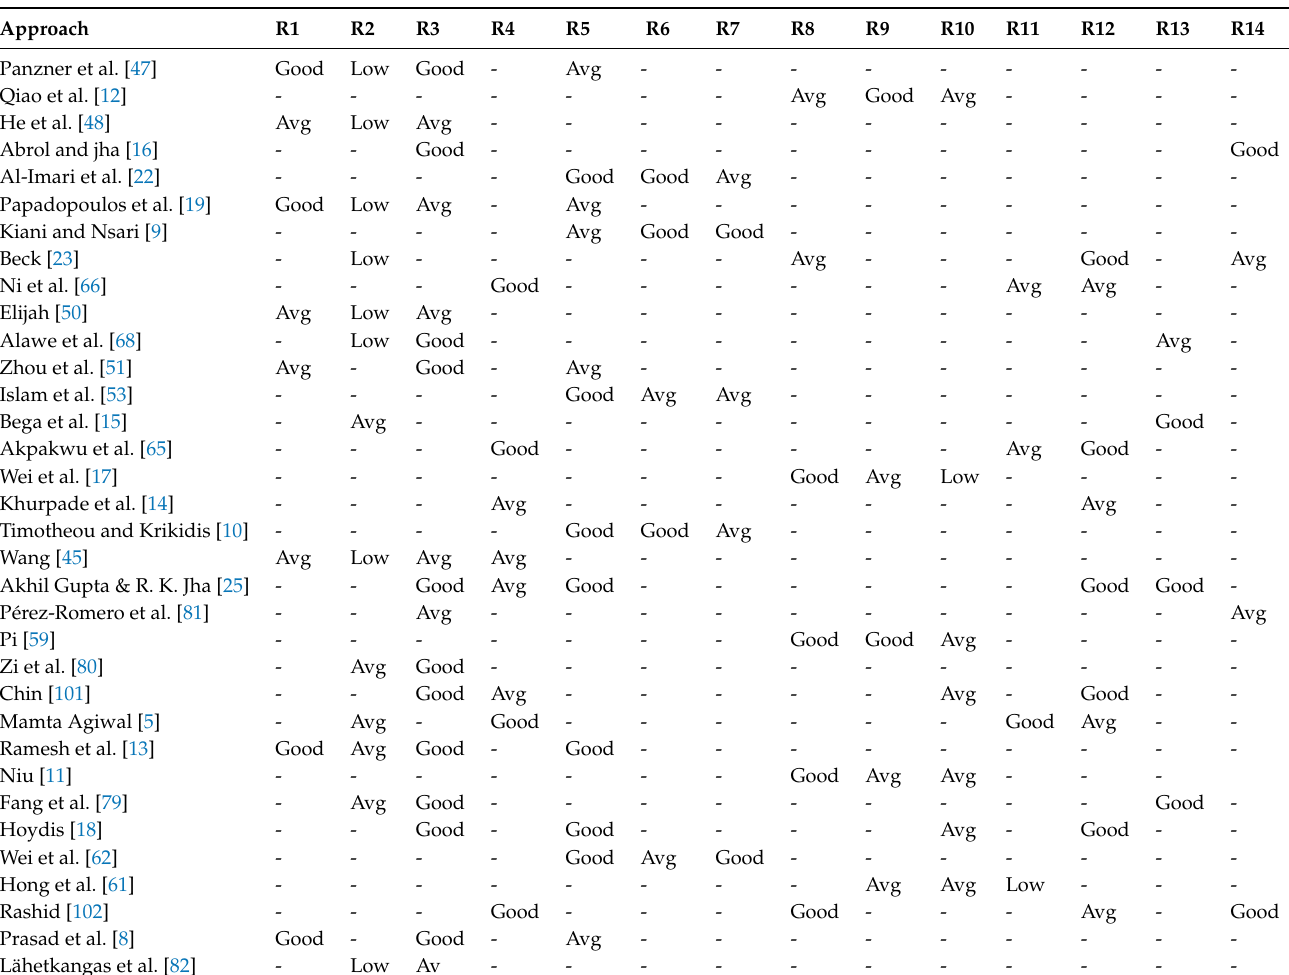
Table 13. Summary of 5G Technology above stated challenges (R1:Throughput, R2:Latency, R3:Energy Efficiency, R4:Data Rate, R5:Spectral efficiency, R6:Fairness & Computing Capacity, R7:Transmission Rate, R8:Coverage, R9:Cost, R10:Security requirement, R11:Performance, R12:Quality of Services (QoS), R13:Power